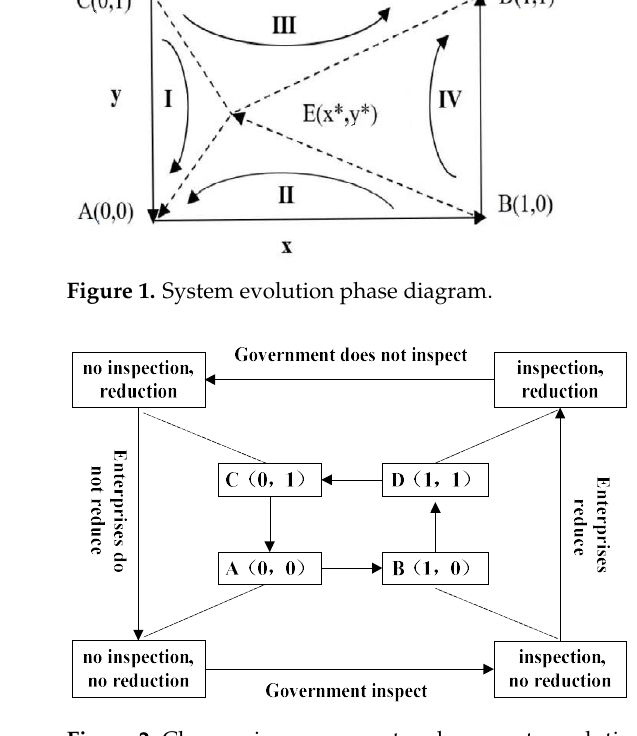
Figure 2. Changes in government and corporate evolution.